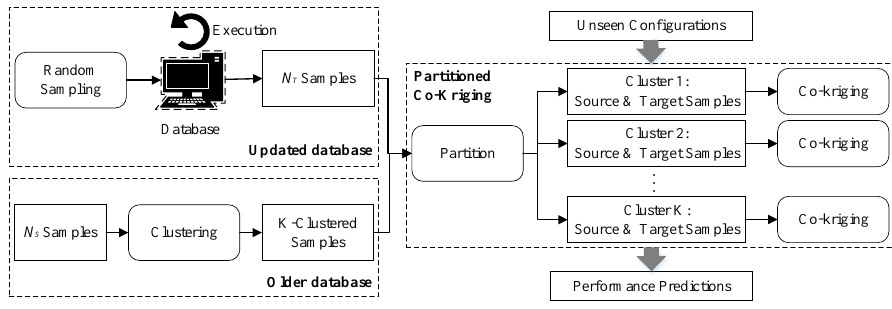
Figure 3. Overview of partitioned co-kriging